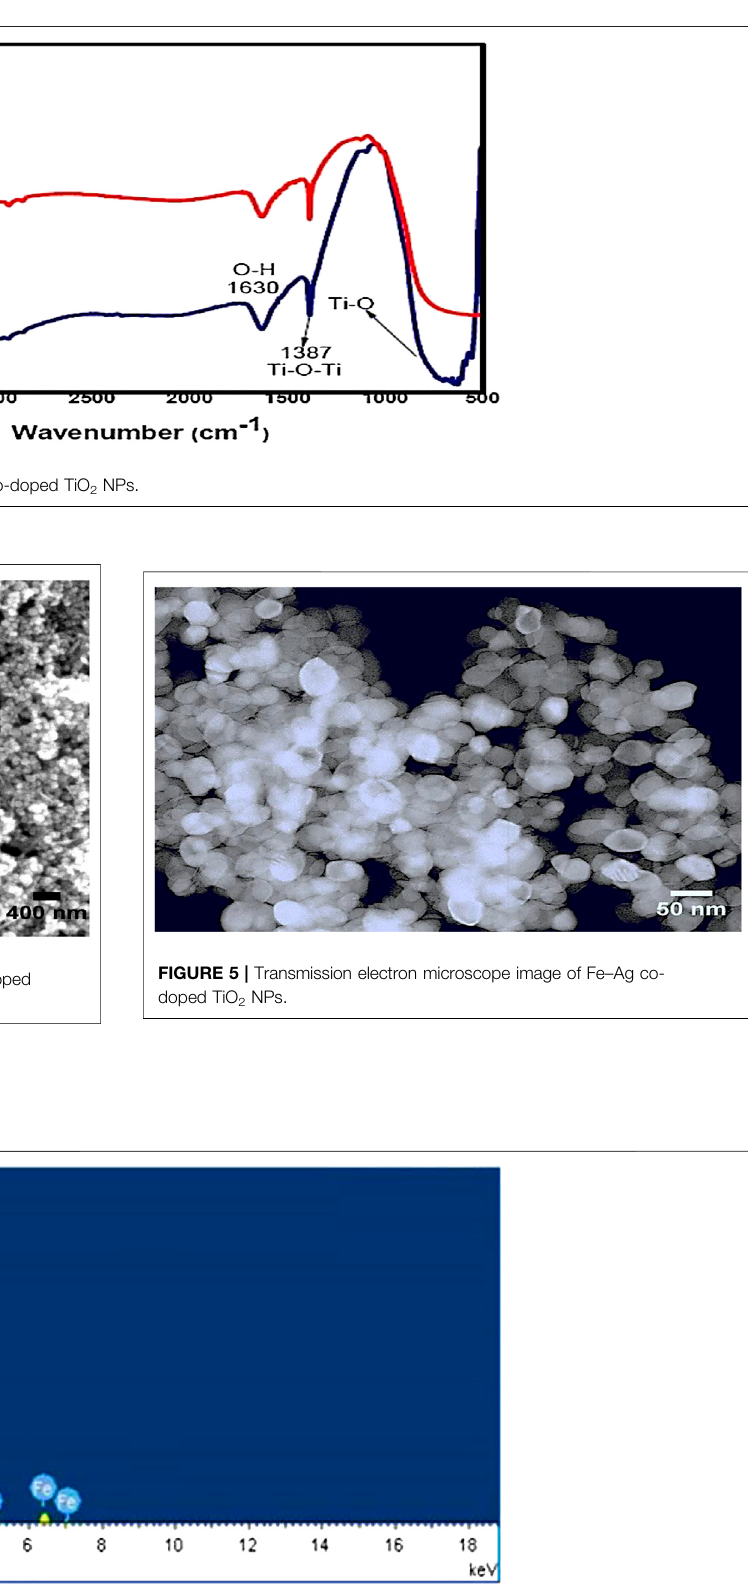
FIGURE 4 | EDS spectra of 1 mmol of Fe – Ag co-doped TiO 2 NPs.